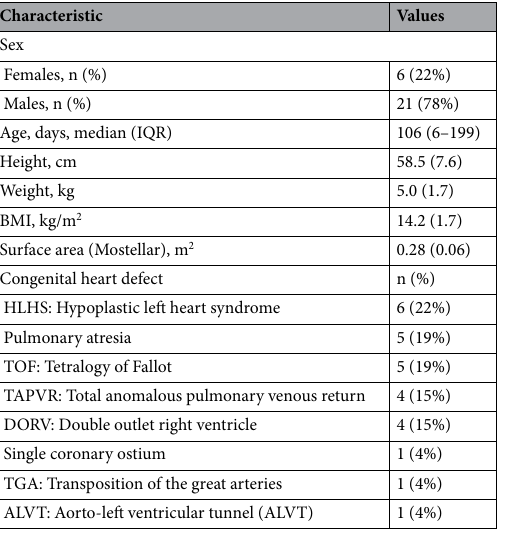
Table 1. A brief overview of the patient characteristics. All values are expressed as mean with standard deviation in brackets unless otherwise noted. IQR Interquartile range, BMI Body mass